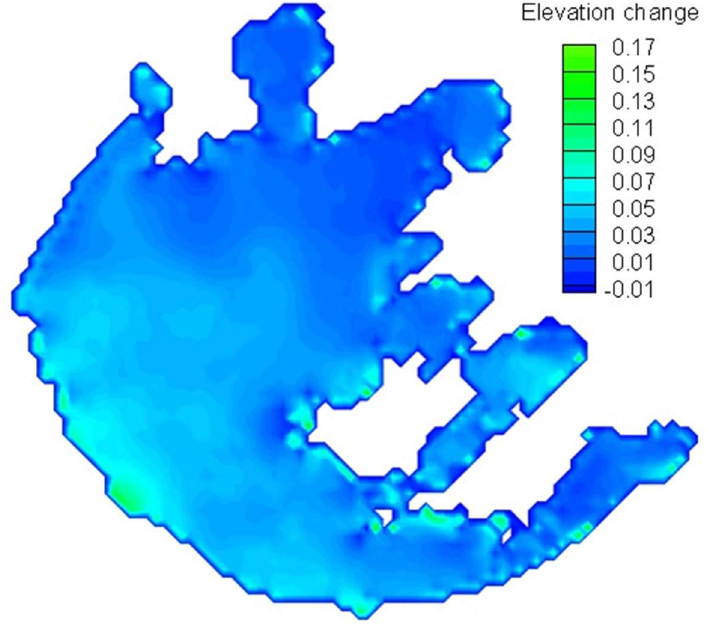
Figure 8. (a) Initial TSM concentration distribution, (b) TSM concentration distribution after 10 days by GOCI data and (c) simulation results after 10 days.